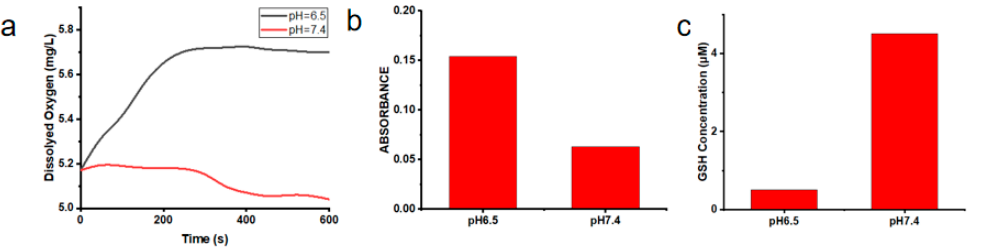
Figure 2. ( a ) the O 2 content under the solution of OCZWM in pH = 6.5 and pH = 7.4. ( b ) The amount of ROS produced by OCZWM in pH = 6.5 and pH = 7.4. ( c ) The GSH content under the solution of OCZWM in pH = 6.5 and pH = 7.4.